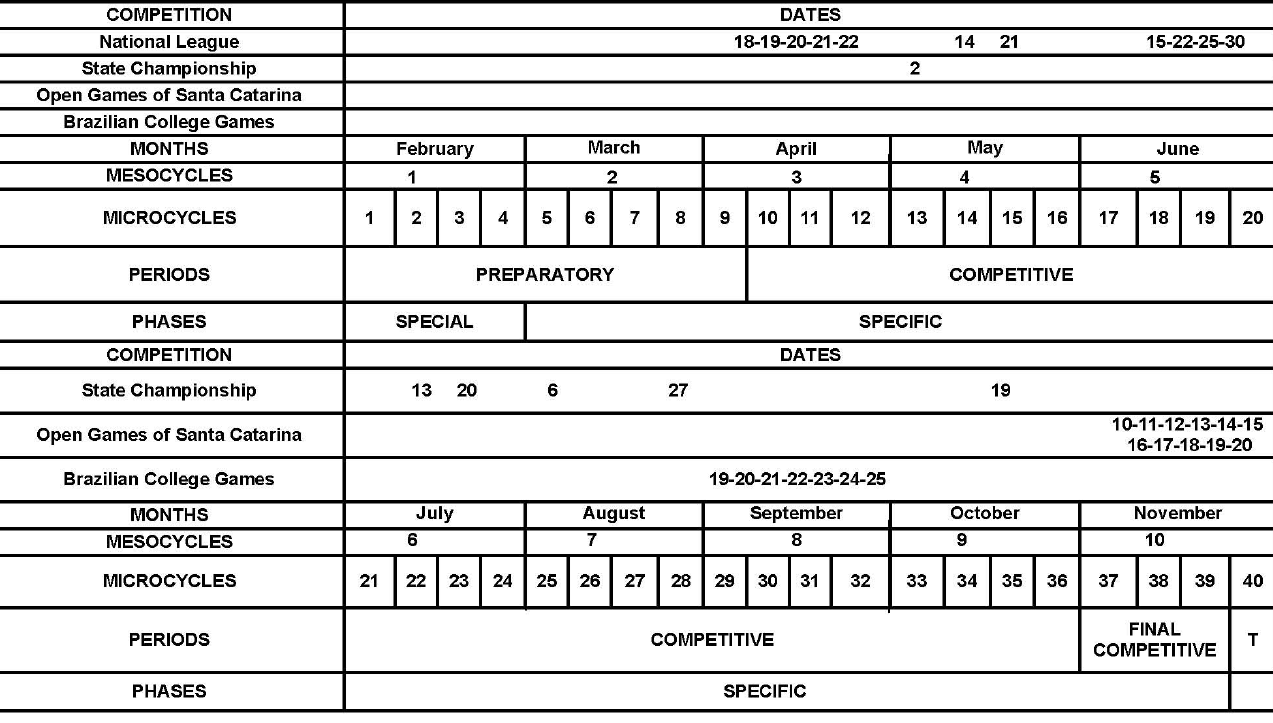
Table 1. Periodization of training from 2011 competitive